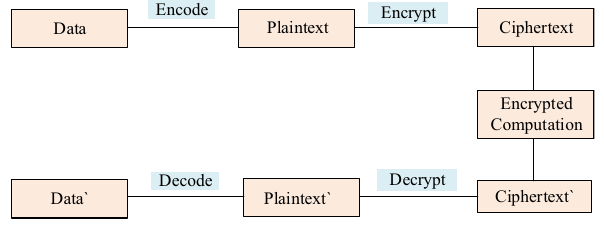
Figure 1: Homomorphic encryption scheme fl ow